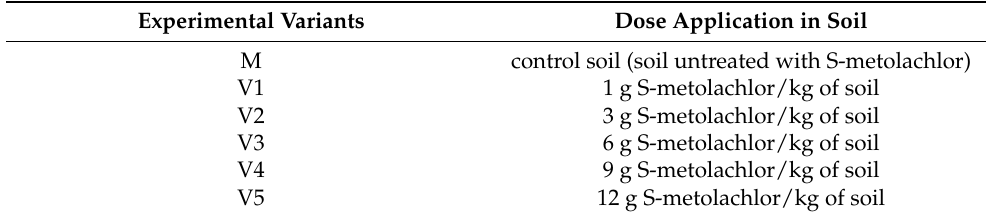
Table 1. Experimental variants considered in this